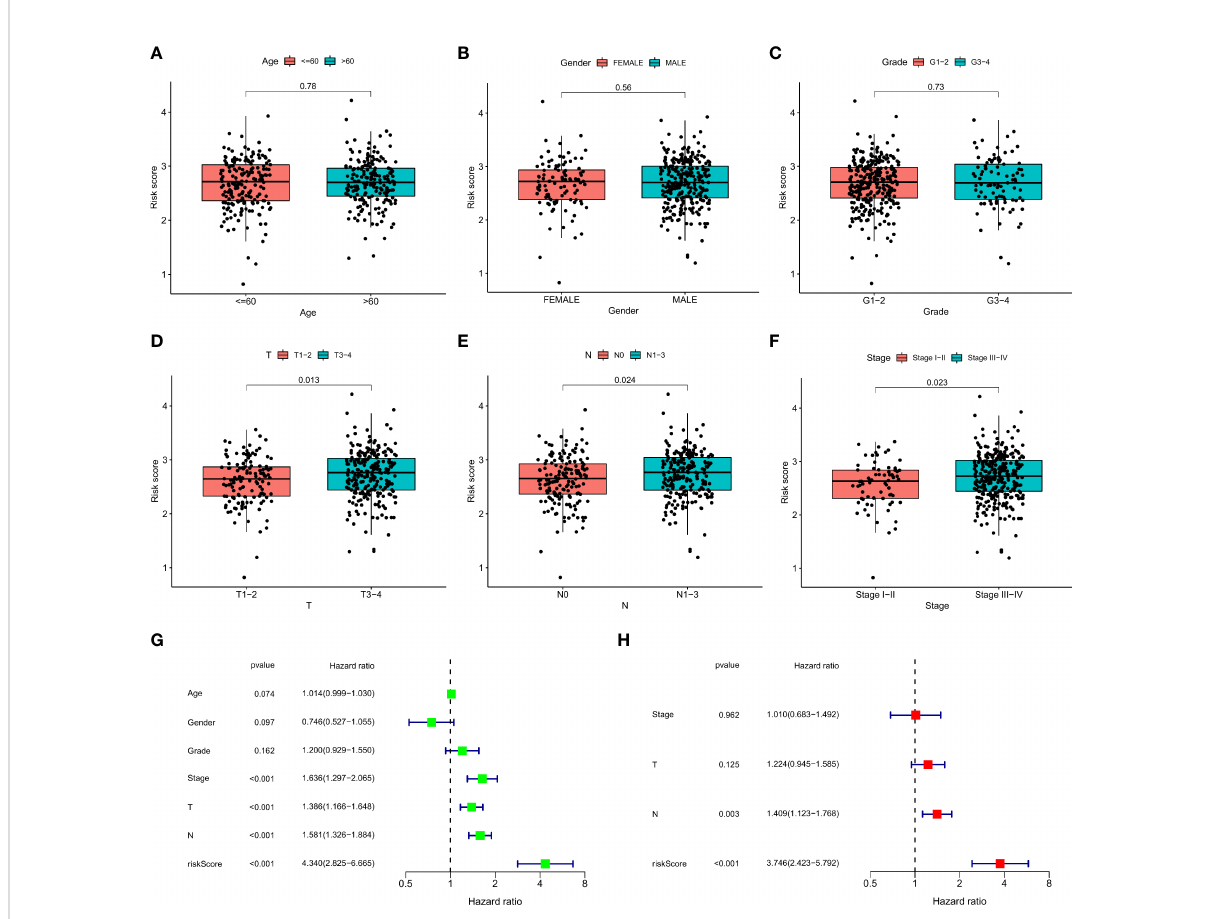
FIGURE 7 The correlations between the risk score and clinical factors (A) age, (B) gender, (C) T, (D) N, (E) stage, (F) and grade. Univariate Cox regression (G) and multivariate Cox regression analyses (H) of risk score and other clinical features were performed in the TCGA